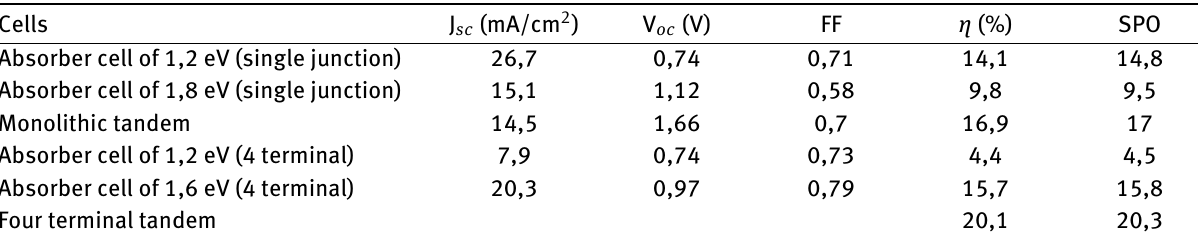
Table 2: Characteristics of the Perovskite / Perovskite tandem cells developed in monolithic and in four-terminal configuration, as well as those of the constituent sub-cells, with an active area of 0.2 cm 2